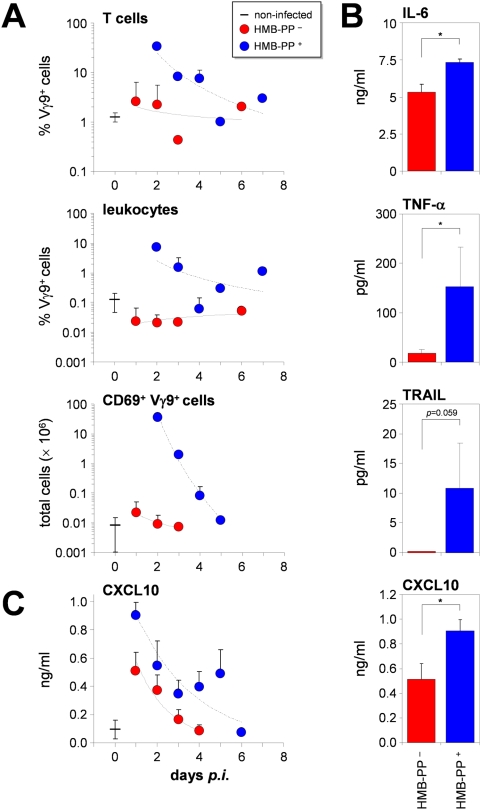
Peritoneal Vγ9/Vδ2 T cells and Vγ9/Vδ2 T cell-induced proteins are increased in HMB-PP+ peritonitis.(A) Frequencies of Vγ9+ T cells among CD3+ lymphocytes (top panel) and total leukocytes (middle panel), and absolute numbers of CD69+ Vγ9+ T cells (bottom panel), as determined in non-infected individuals (n = 5–7), and patients with HMB-PP+ (Bacteroides splanchnicus, E. coli, Leclercia adecarboxylata, Proteus vulgaris) (n = 5) or HMB-PP− peritonitis (Staphylococcus epidermidis, α-hemolytic Streptococcus spp.) (n = 8–13). (B) Peritoneal cytokine levels±SEM on day 1 p.i., and (C) time course of CXCL10 levels over 6 days p.i. in cell-free effluent fluid from patients with HMB-PP+ (E. coli, Neisseria sp., Proteus sp., Pseudomonas sp., unspecified coliform and coryneform bacteria) (n = 7–10) or HMB-PP− peritonitis (Staphylococcus aureus, Staphylococcus epidermidis, α-hemolytic Streptococcus spp.) (n = 13–16).